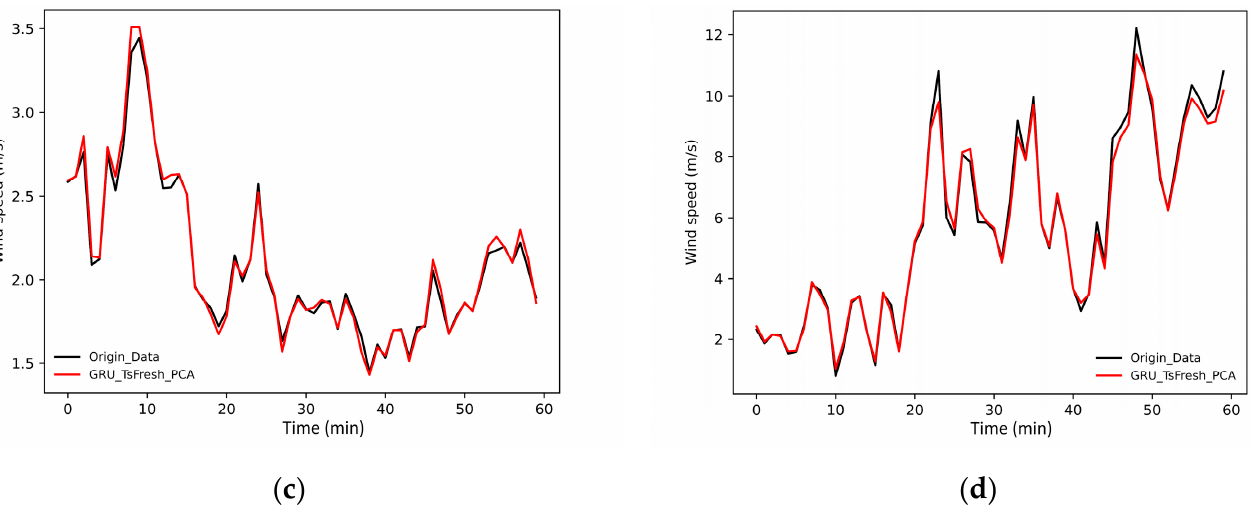
Figure 7. Comparison of predicted and actual values for the four datasets. ( a ) Comparison of predicted and actual values for the spring dataset; ( b ) comparison of predicted and actual values for the summer dataset; ( c ) comparison of predicted and actual values for the autumn dataset; ( d ) comparison of predicted and actual values for the winter dataset. The prediction error histograms for the four seasonal data sets are shown in Figure 8. It could be seen that the maximum error was less than 1 m/s. According to the prediction evaluation index, the prediction accuracy of the hybrid model met the requirements.